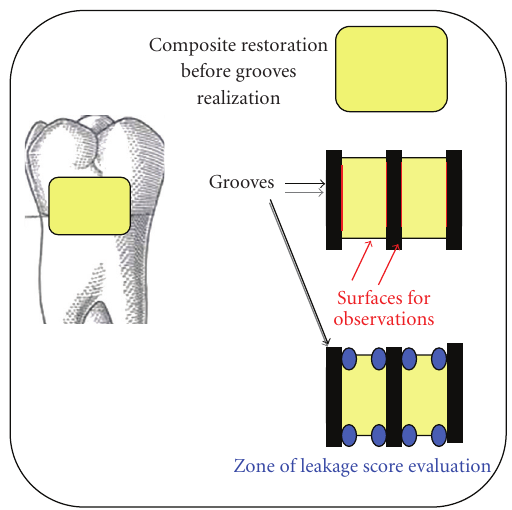
Figure 1: Illustration of the 3 grooves cut on the composite filling and the resulting 8 lecture areas.